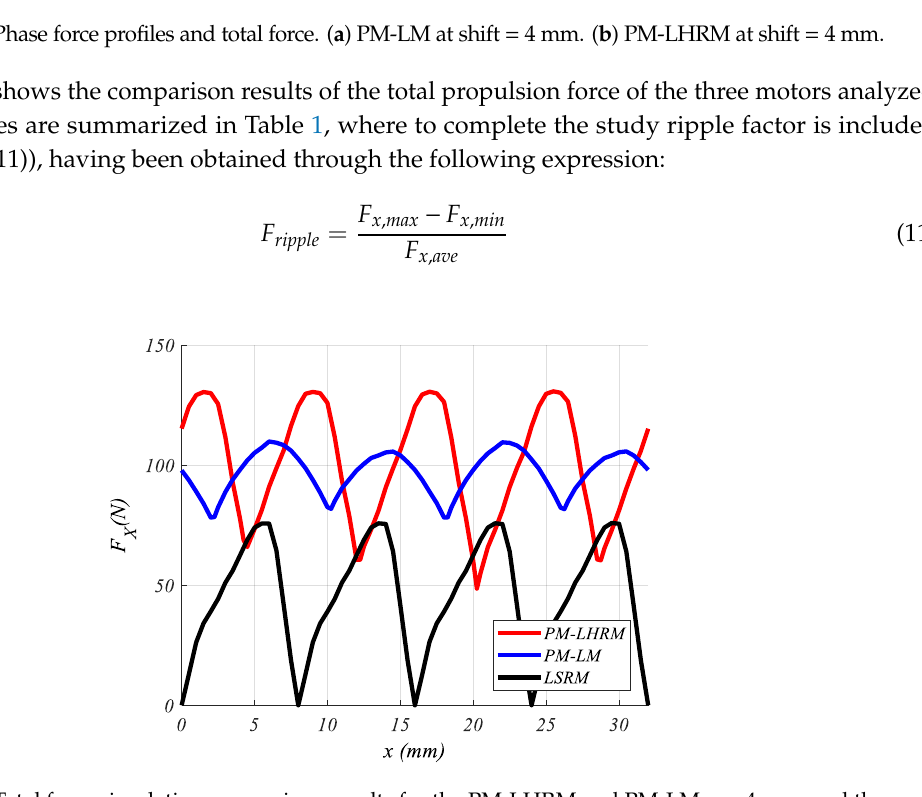
Figure 10. Phase force profiles and total force. ( a ) PM-LM at shift = 4 mm. ( b ) PM-LHRM at shift = 4 mm.